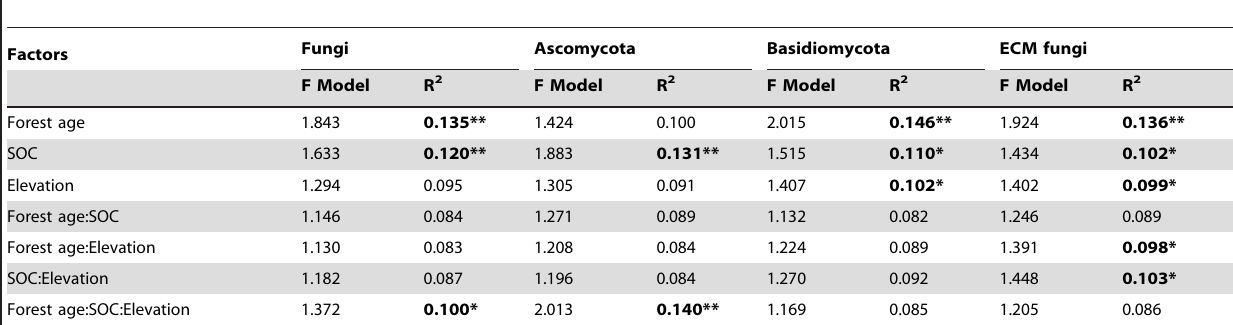
Table 3. Influence of forest age, elevation of the study site and soil organic carbon (SOC) on the fungal community composition.